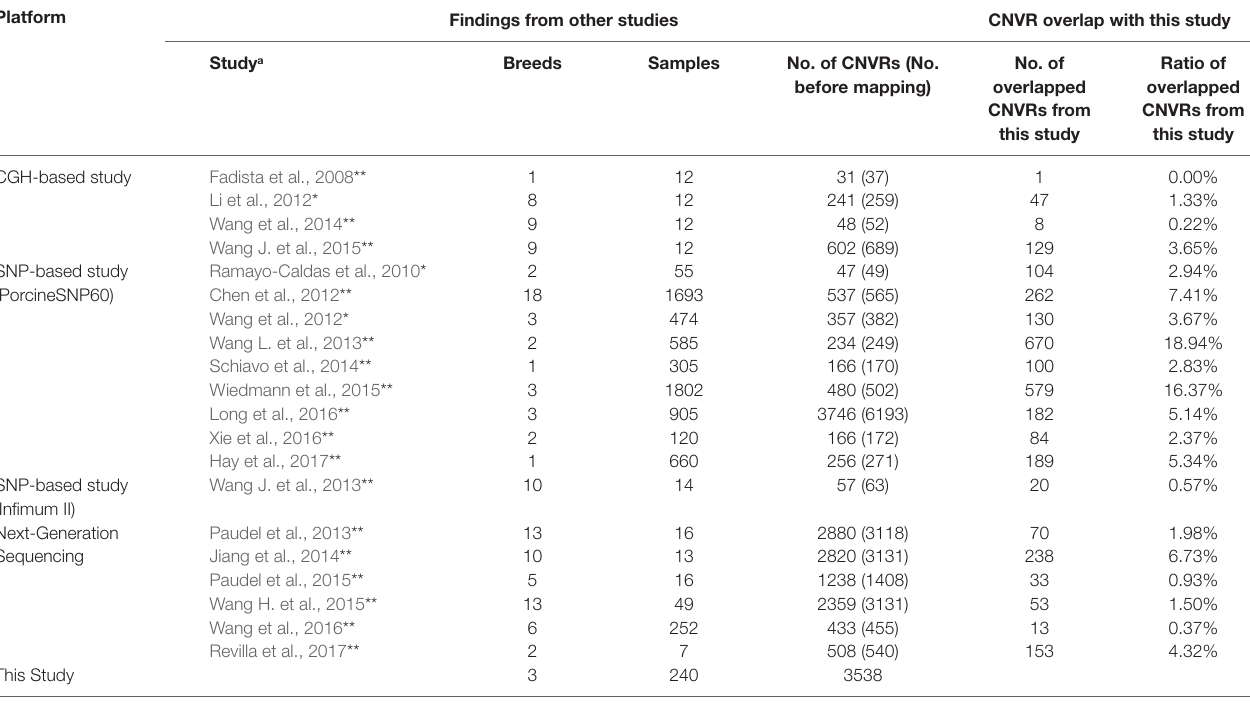
TABLE 3 | Comparison of CNVRs identified in this study to results from other studies (based on the Sscrofa 11.1 genome assembly).